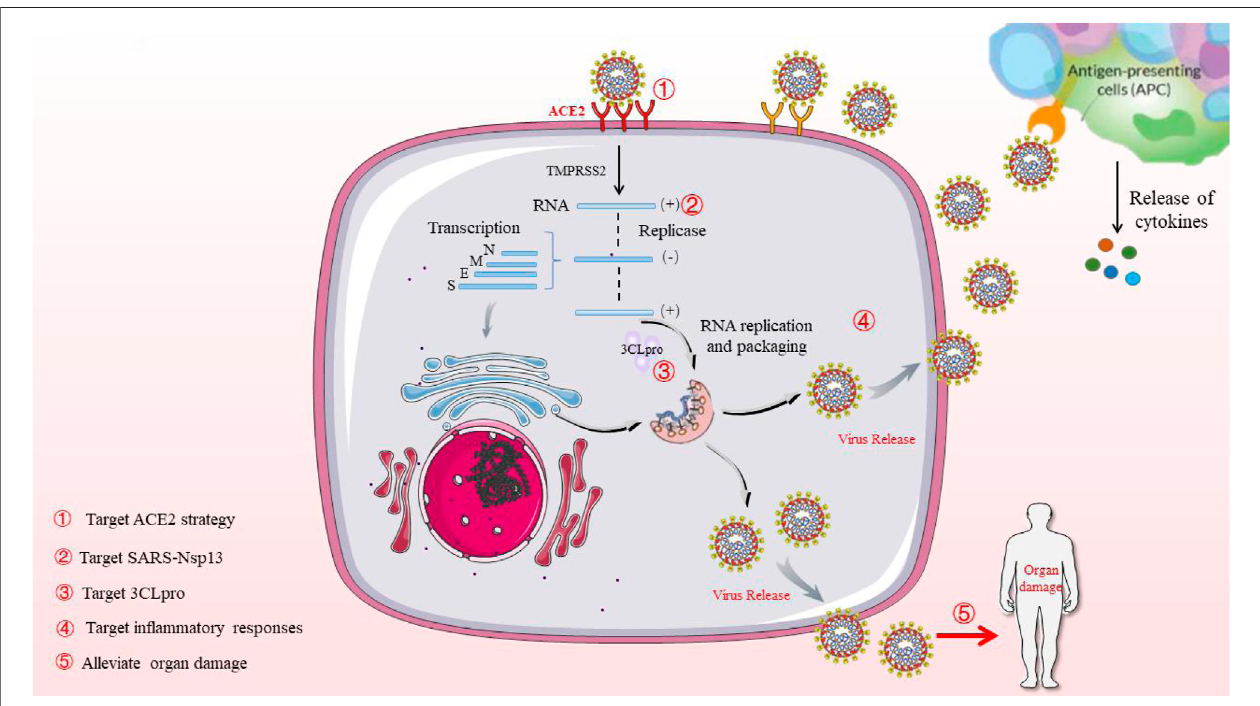
FIGURE 2 | Possible life cycle of SARS-CoV-2 and potential intervention